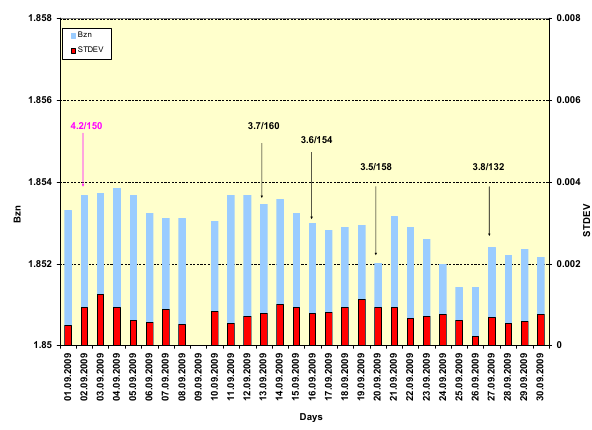
Fig. 7. Bzn and STDEV distributions at the GOPS, within the in- terval 1 September–30 September 2009; Vertical arrows are earth- quakes; ratio 4.2/150 is magnitude/hypocentre depth of earthquake.